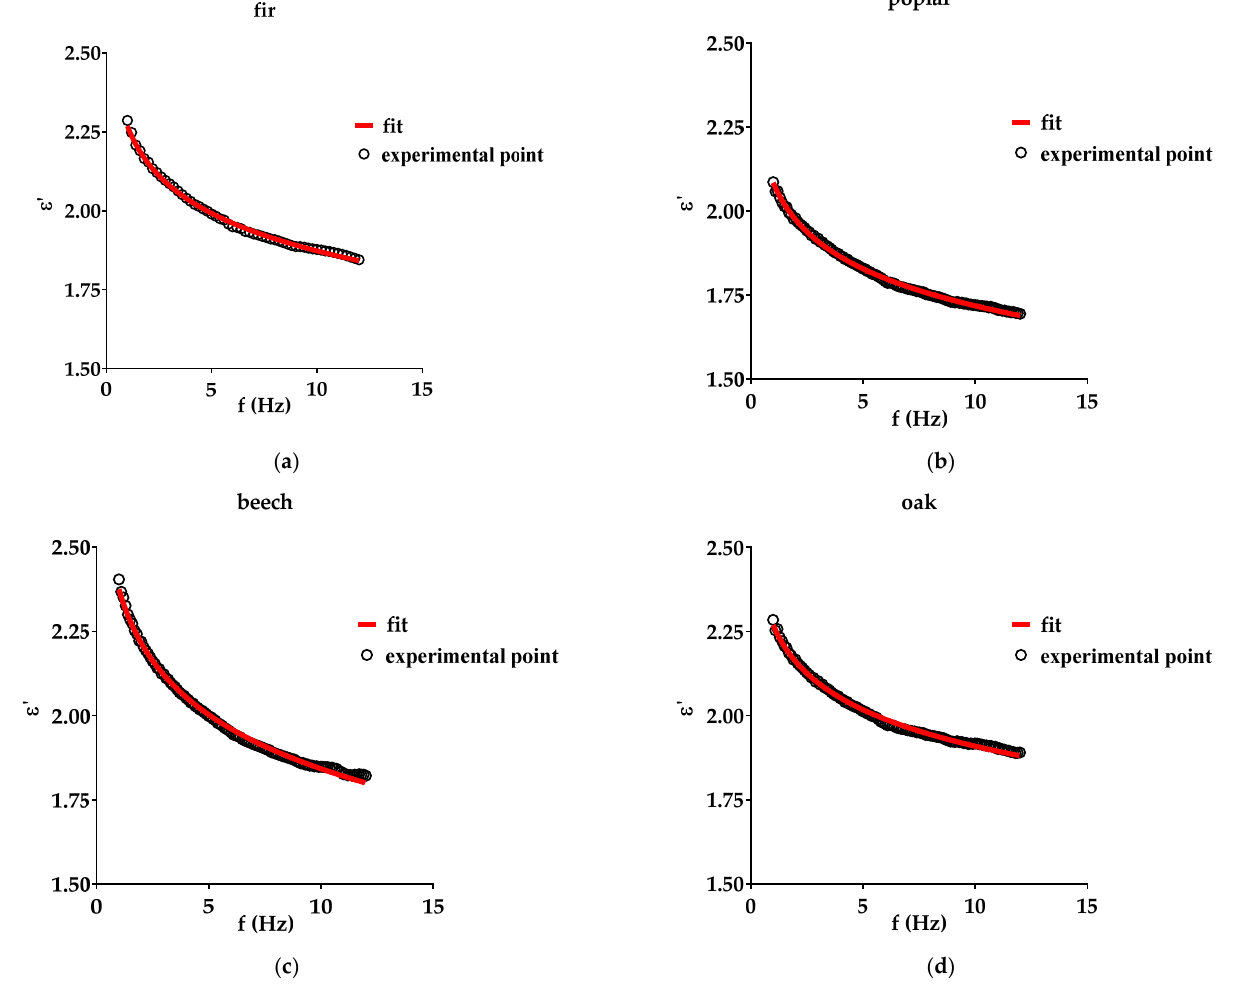
Figure 3. This figure reports the relations between the real part of permittivity ε ’ and frequency f at the dry condition with highlighted in red the log-fit: ( a ) fir ε ’– f relationship; ( b ) poplar ε ’– f relationship; ( c ) beech ε ’– f relationship; ( d ) oak ε ’– f relationship. Measurements were conducted with a customized open-ended probe.